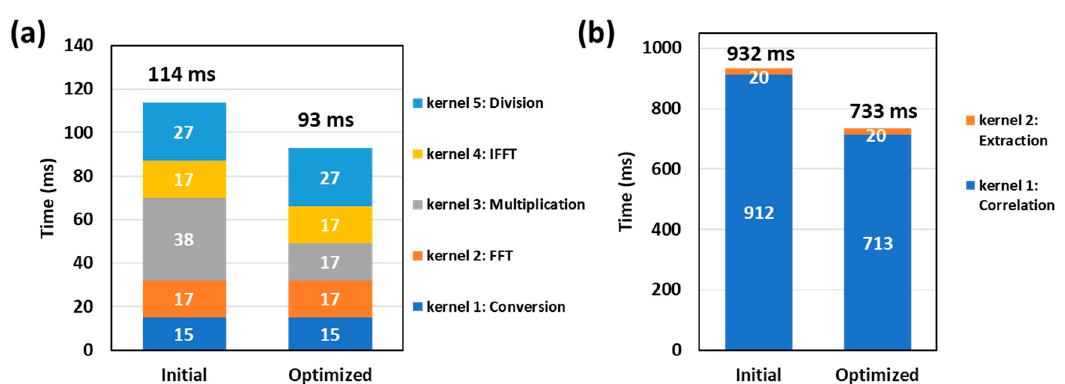
Figure 7. Kernel runtimes. ( a ) Hilbert transformation. ( b ) Correlation calculation.